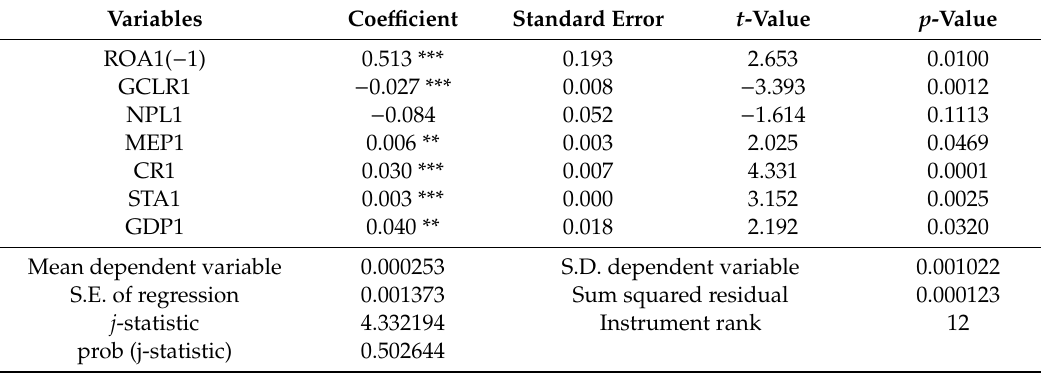
Table 3. Model 1 regression results for Chinese commercial banks.